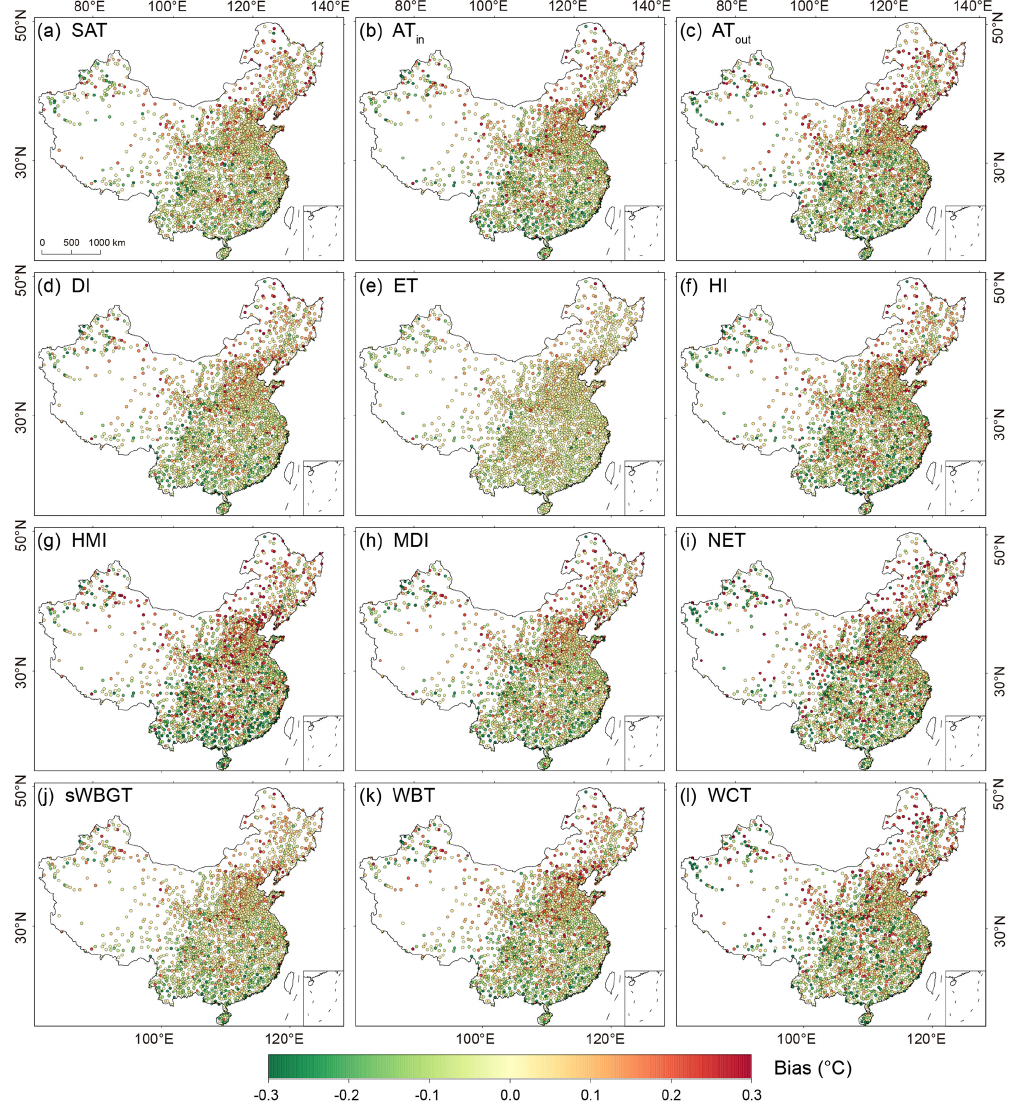
Figure 7. As Fig. 4 but for